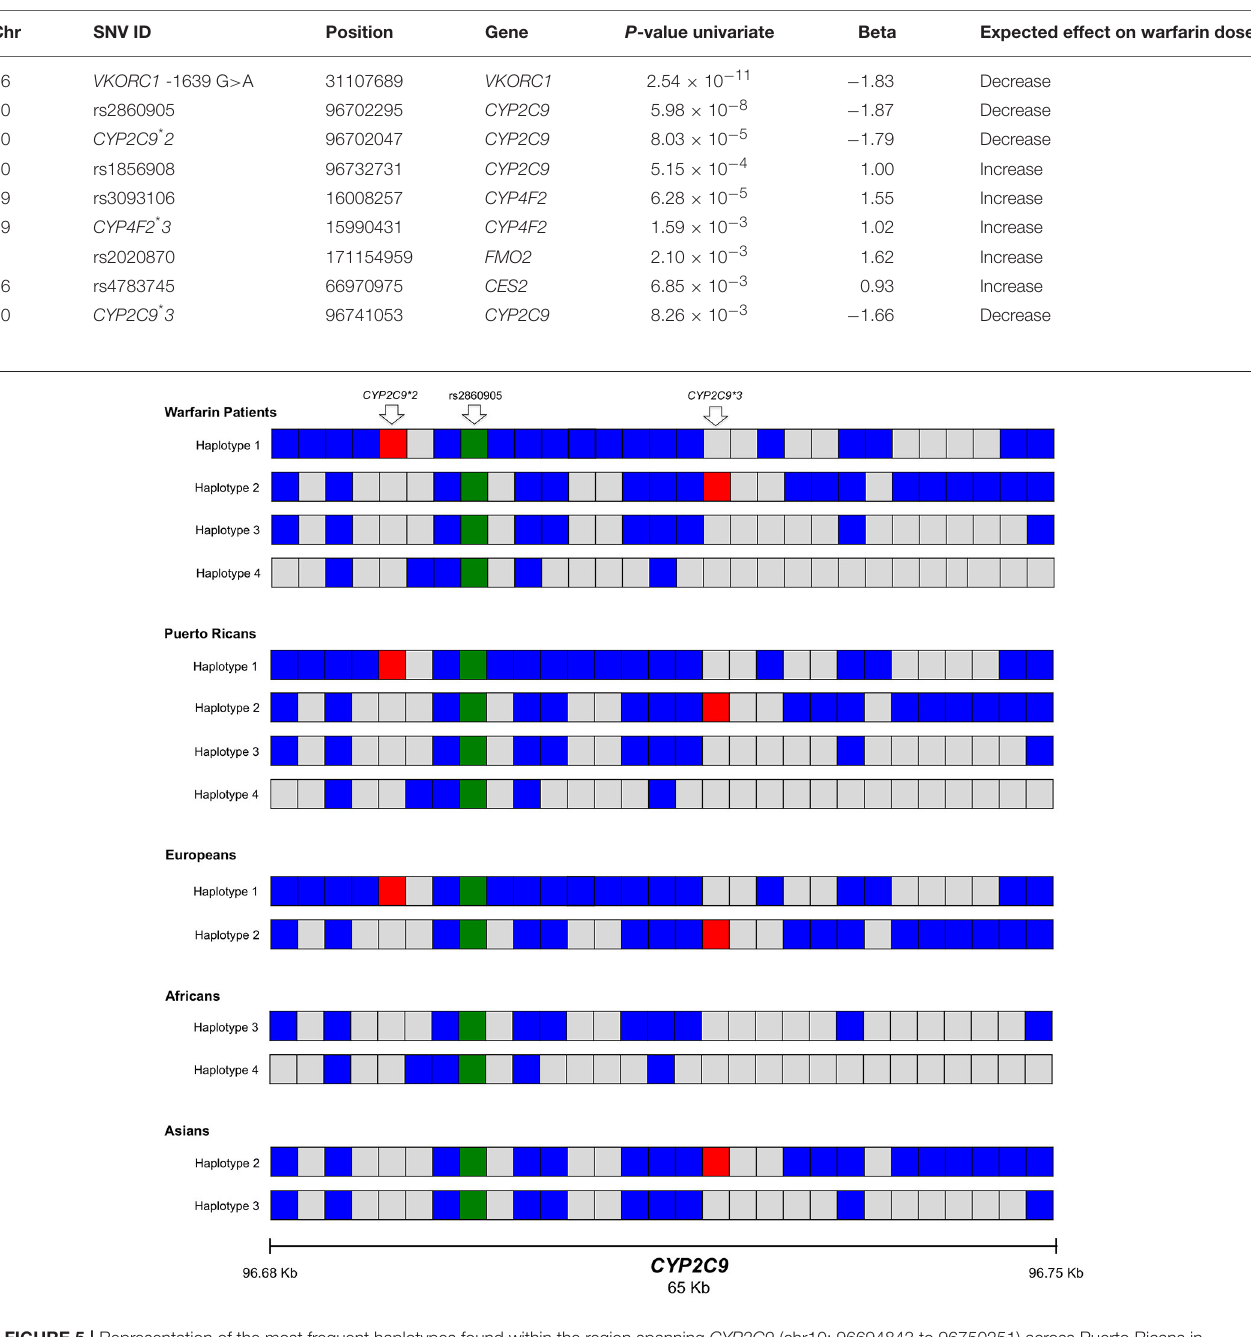
FIGURE 5 | Representation of the most frequent haplotypes found within the region spanning CYP2C9 (chr10: 96694843 to 96750251) across Puerto Ricans in warfarin and parental populations from the 1000 Genomes Project (Caucasians, Africans and Asians). Each block represents a position within the haplotype (haplotypes 1-4, H1-4). Blue blocks indicate the presence of the variant allele for each of the positions while gray blocks indicate the presence of the wild-type allele. The green block is the presence of the variant rs2860905. Red blocks represent the variants CYP2C9 * 2 (rs1799853) and CYP2C9 * 3 (rs1057910). The data was obtained from the 1000 Genomes Project Phase 3 with phased genotypes.